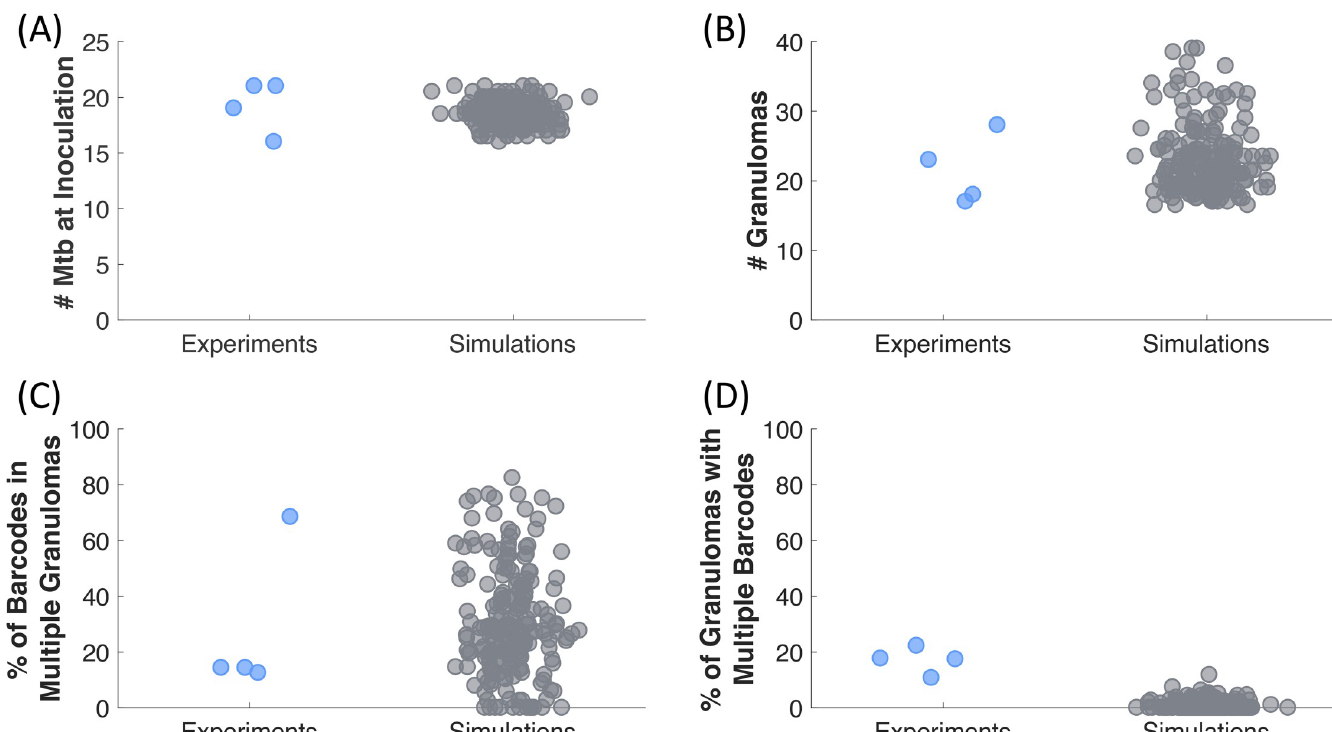
Fig 6. MultiGran recapitulates non-human primate dissemination outcomes. Martin et al. [25] infected 4 NHP with 16–21 different Mtb barcodes (A) , and after 120 days the NHP immune system formed 16–28 non-sterilized granuloma clusters (B) . We replicated these experiments by simulating 200 NHP, which started with 16–21 different Mtb. Of the 16–21 Mtb in NHP, 10%-70% were found in multiple granuloma clusters, meaning at least 10%-70% of Mtb were disseminating. Similar to the NHP data, our simulations have 0%-90% of Mtb barcodes disseminated to multiple granuloma clusters (C) . Within the NHP experiments, of the 16–28 non-sterilized granuloma clusters, 10%-25% had multiple Mtb IDs within them, meaning at least 10%-25% of observed granulomas are clusters involving multiple sources of Mtb infection. Our 200 MultiGran simulations demonstrate a similar range of granuloma clusters with multiple Mtb barcodes (D) . Simulations are shown in gray whereas NHP experiment outcomes are shown in blue. Each point represents a single NHP or in silico simulated granuloma.